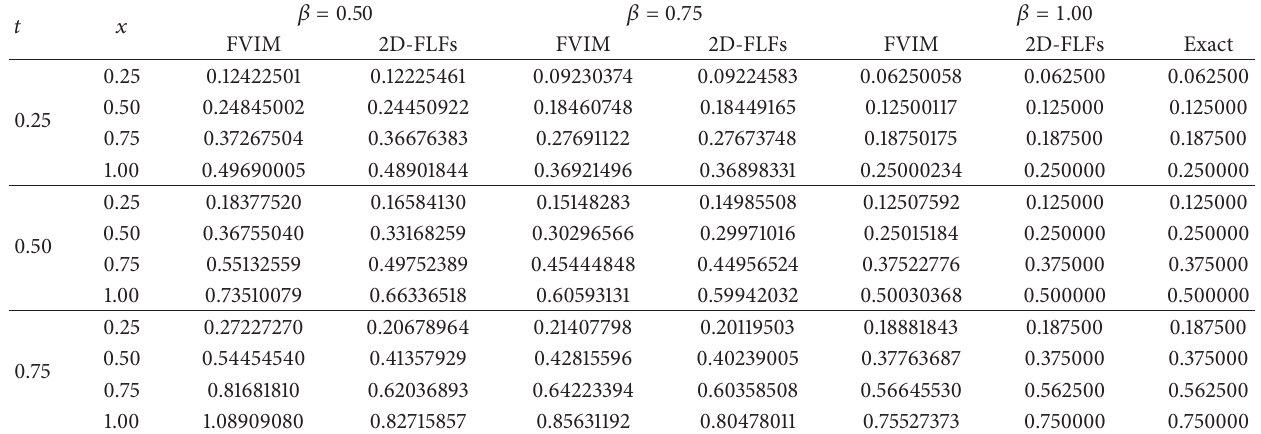
Table 2: Numerical values when 𝛽 = 0.50, 0.75, and 1.0 for (61).